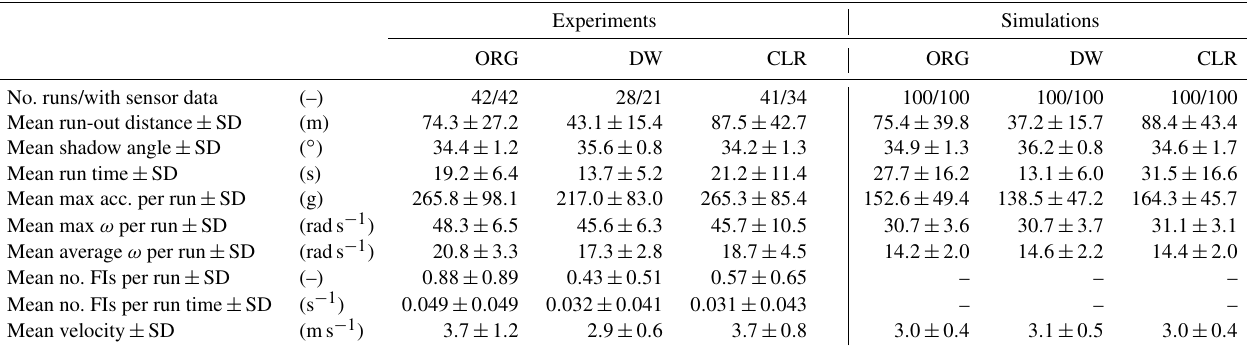
Figure 3. Example of three typical StoneNode data streams (a) – (c) measured within the 45kg EOTA 111 rocks (d) : in blue the resulting rotational velocities and in green the resulting impact accelerations of (a) an ORG run, (b) a DW run and (c) a run within the CLR stand. The confirmed frontal impacts (FIs) therein are marked as large black crosses; their flagging procedure exemplified in (e) and (f) for two hits are outlined in gray in (b) . (e) Smoothed rotations ω with different moving-window sizes and (f) segment slopes m of linear segments in smoothed ω . If falling below the moving-window specific threshold, the impact is flagged as a possible FI (small black crosses) and as a confirmed FI if at least three flags are produced for the same impact. Table 1. Resulting statistics of the experiments (left) and simulations (right) for the original state of the forest ORG; the state with lying, fresh deadwood (DW); and the deadwood-cleared area